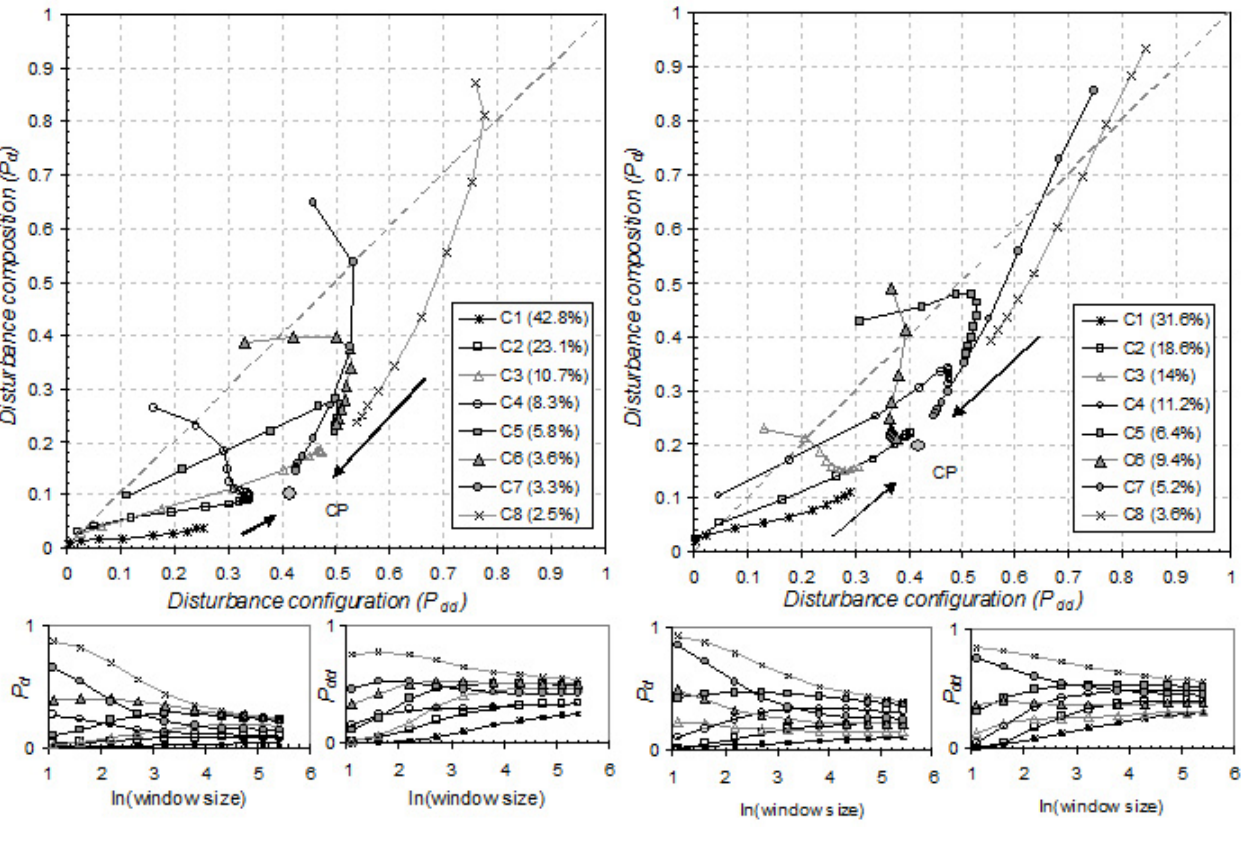
Fig. 2. Pattern state space [P , P ] defined by composition (P ) and configuration (P ) and disturbance d dd d dd trajectories at multiple scales (10 window sizes) for eight clusters (C1-C8) representing disturbance patterns in Apulia in the period 1997–2001. On top, the two figures correspond to an overall P = 0.10, i. d e., disturbance of 10% (left), and P = 0.20, i.e., disturbance of 20% (right) respectively, with P in both d dd cases about 0.41. The percentage of pixels belonging to each cluster is given in the legend. All trajectories converge from the finest to the coarsest scale, i.e., from smallest to largest window size, on a regional point called convergence point (CP). Below, the single trajectories of P and P vs. scale (10 d dd window sizes) are shown (see text; adapted from Zurlini et al. 2006,